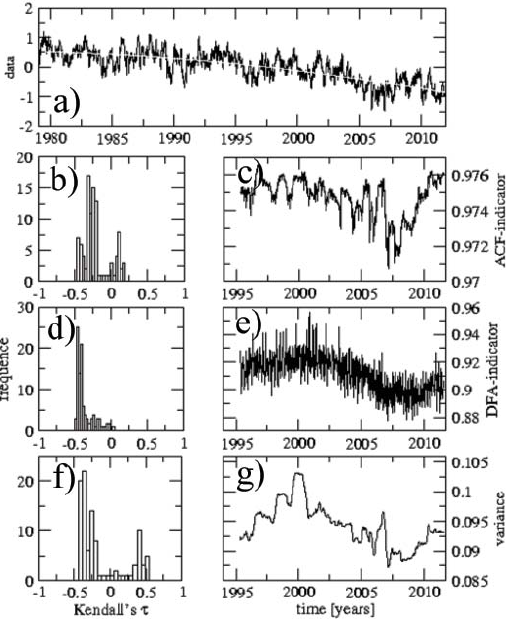
Fig. 9. Search for early warning signals of bifurcation in winter– spring Arctic sea-ice area. (a) Winter–spring sea-ice area anomaly (as in Fig. 7c) showing the quadratic downward trend that is re- moved prior to calculating the instability indicators. Right panels show example indicators from (c) autocorrelation function (ACF), (e) detrended fluctuation analysis (DFA) and (g) variance, results plotted at end of a sliding window of length half the series. Left panels show histograms of the Kendall statistic for the trend in the indicators when varying the sliding window length from 1/4 to 3/4 of the series: (b) ACF-indicator; (d) DFA-indicator; (f)